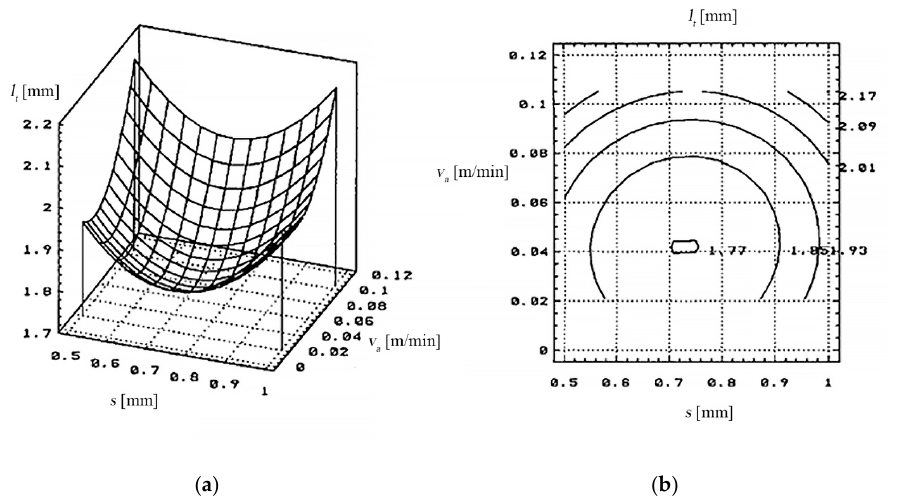
Figure 17. The dependency of the cutting width ( l t ) to the thickness ( s ) of the metal band and the feeding rate ( v a ) of the processing object: ( a ) 3D graph; ( b ) 2D